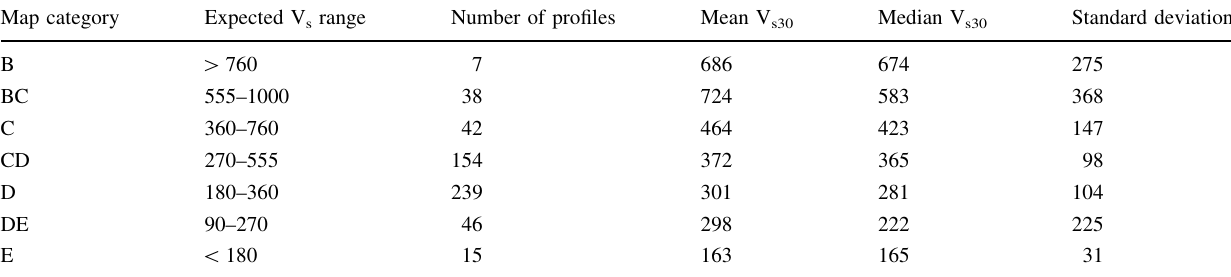
Table 2 Summary of measured V s30 in California, United States. Source : Wills et al. (2000) Map category